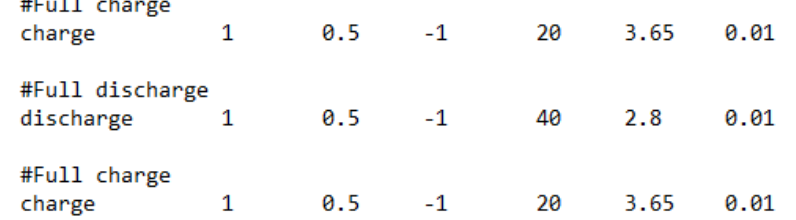
Figure 13. The test sequence adopted to measure the available charge in a cell, as described in the